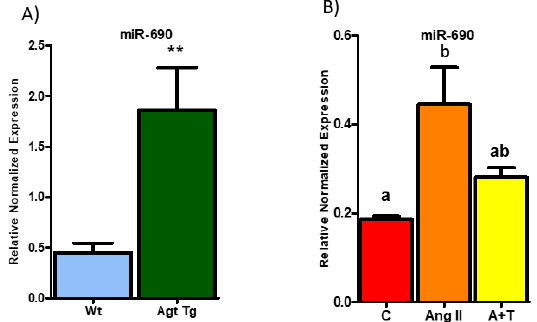
Figure 2. Renin–angiotensin system (RAS) overexpression induces miR ‐ 690 expression in both epididymal white adipose tissue (WAT) and adipocytes. ( A ) miR ‐ 690 expression is significantly higher (3 ‐ fold) in WAT in mice overexpressing angiotensinogen (Agt Tg) compared to wild type (Wt) mice (** p < 0.001) ( n = 8). ( B ) Angiotensin treatment in 3T3 ‐ L1 adipocytes significantly increased miR ‐ 690 levels compared to control group, and miR ‐ 690 expression was reduced with RAS inhibitor telmisartan (trending with p ‐ value 0.09) compared Ang II treated group (C = control, A = Ang II, A+T = Ang II + Telmisartan). Common letters on the error bars indicate no significance (e.g., “a” is significantly different from “b” and “ab” indicates no significance compared to “a” and “b”). Data is presented as mean ± SEM ( p < 0.05). ( n = 4).